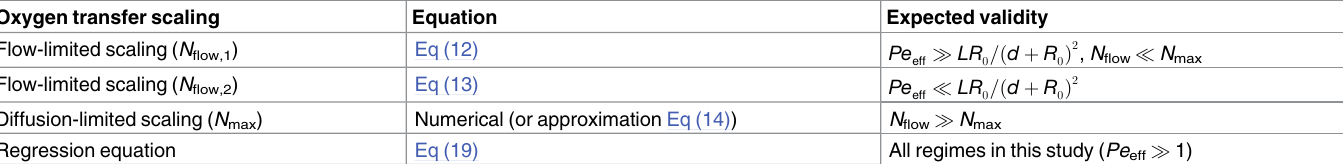
Table 1. Summary of oxygen transfer scaling results for Pe eff = Bu 0 R 0 / D (cid:29)